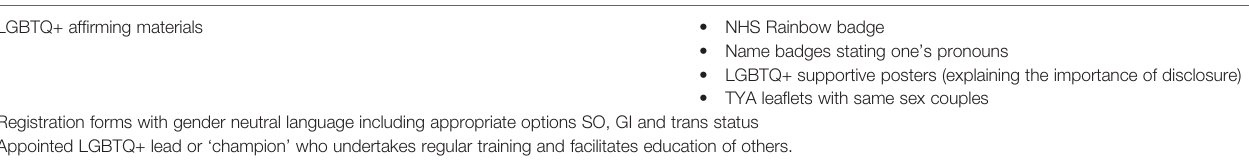
TABLE 4 | Recommended changes at the organisational level to bring lasting change for LGBTQ+ health. LGBTQ+ af fi rming